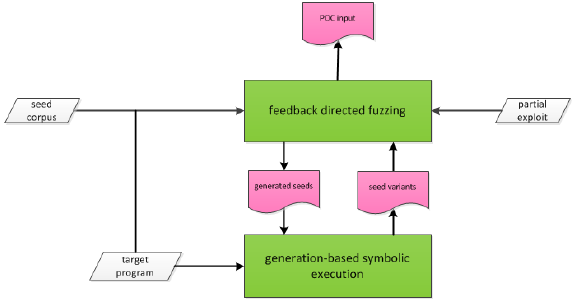
Figure 4. Overview of hybrid